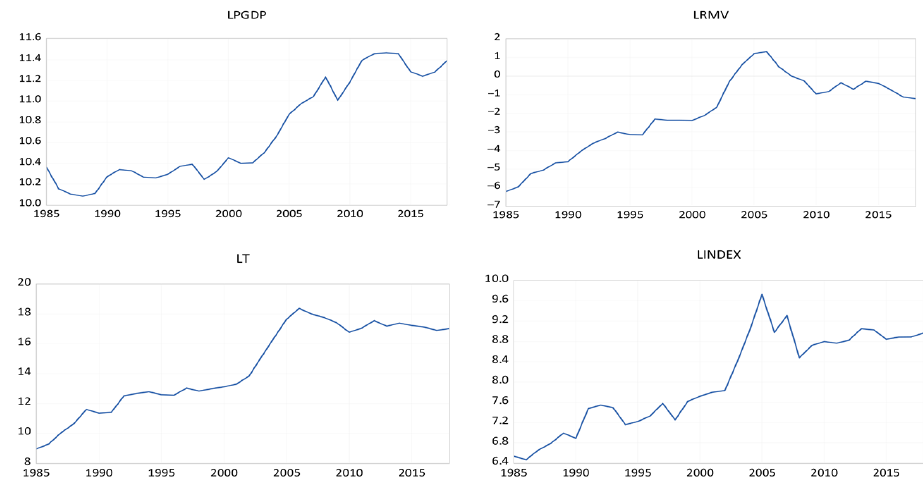
Figure 1. Per-capita GDP, share of market value and transactions to GDP and market index (in